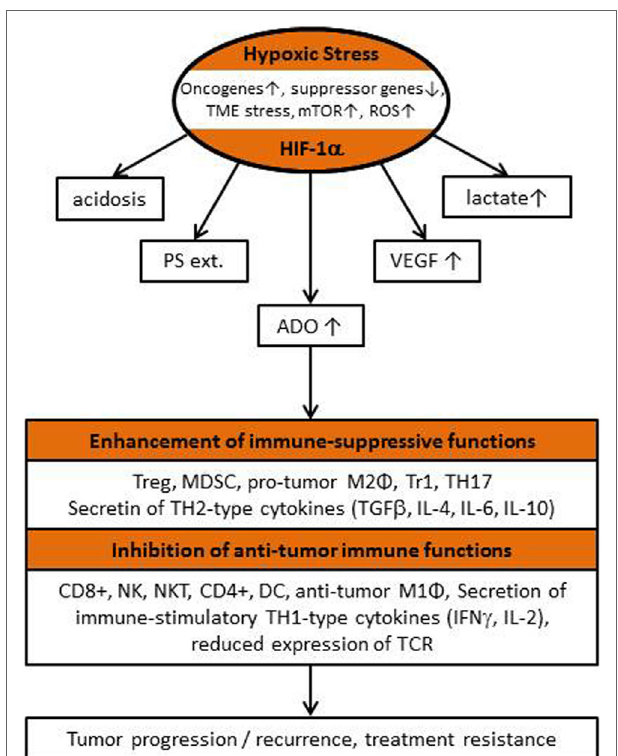
FiGURe 2 | Flow chart describing “classical” hypoxia-/HIF-1 α -driven features of the tumor microenvironment (TME) responsible for the local inhibition of antitumor immunity, for tumor progression/recurrence and poor patient outcome (see also list of